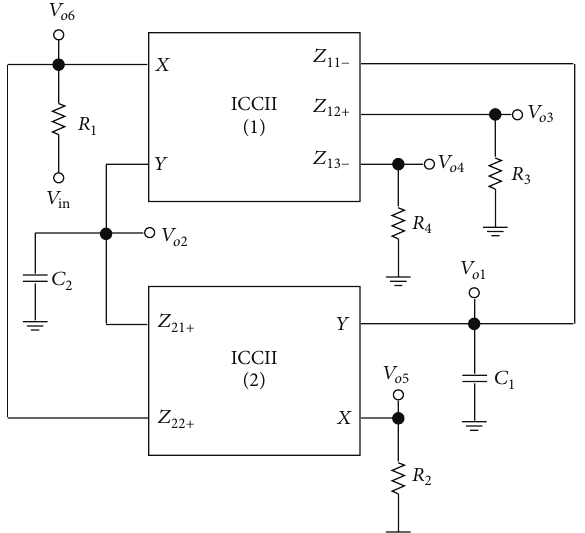
Figure 3: The proposed ICCII-based voltage-mode inverting and noninverting low-pass, bandpass, and high-pass filter.